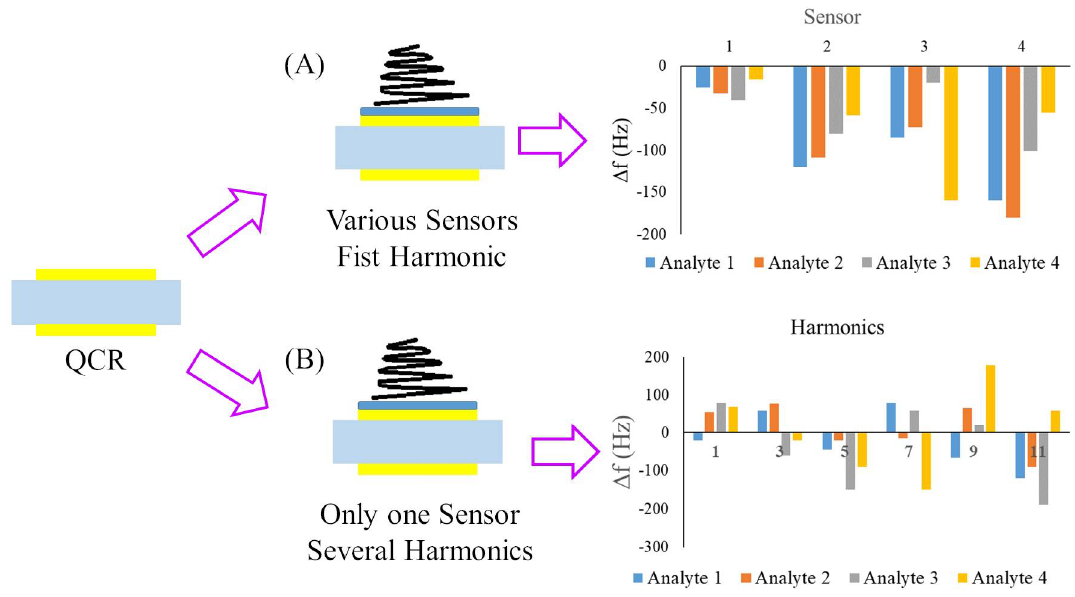
Figure 9. Schematic representation of ( A ) a QCM-based MSA and ( B ) a QC-based